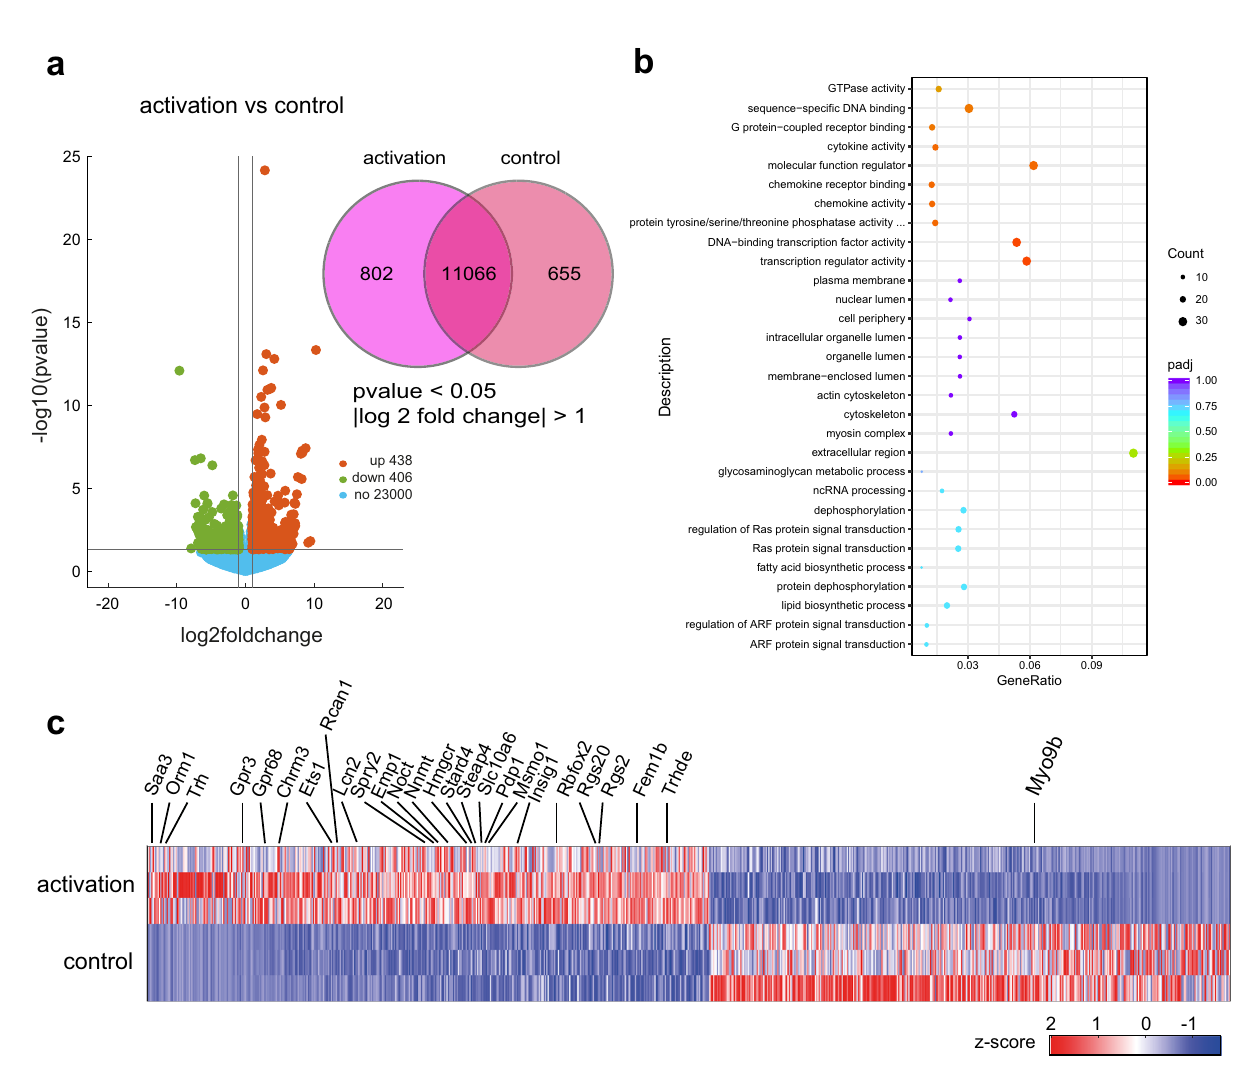
Fig. 8 | M5 tanycyte activation leads to differential regulation of metabolism- related genes. a (right) Venn diagram showing exclusively expressed genes and (left) Volcano plot illustrating genes differentially regulated in activated M5 tany- cytes compared with controls by RNA-seq ( p -values were obtained via Wald test with DESeq2 package, n =3 samples). b Scatter Plot of GO terms enriched from upregulatedgenesinactivatedTRPM5tanycytes.Thecolorandsizeofthedotsare